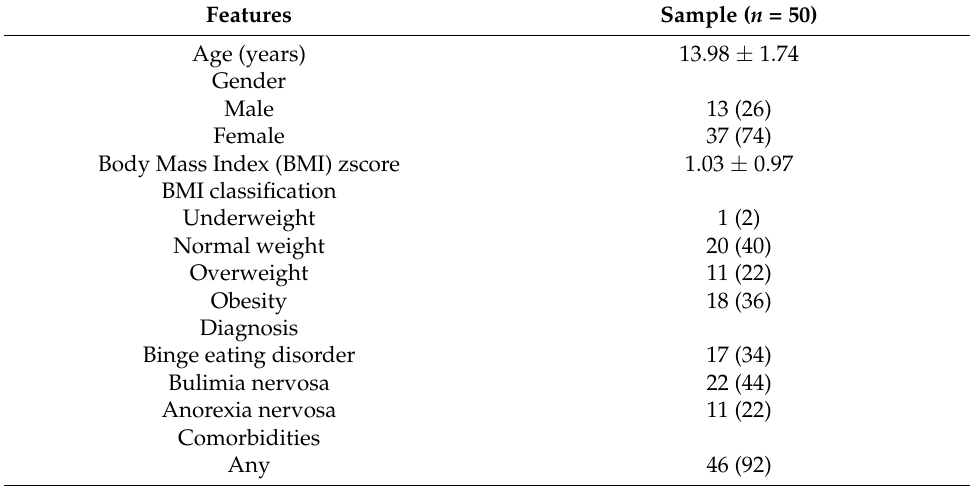
Table 1. Clinical features of study